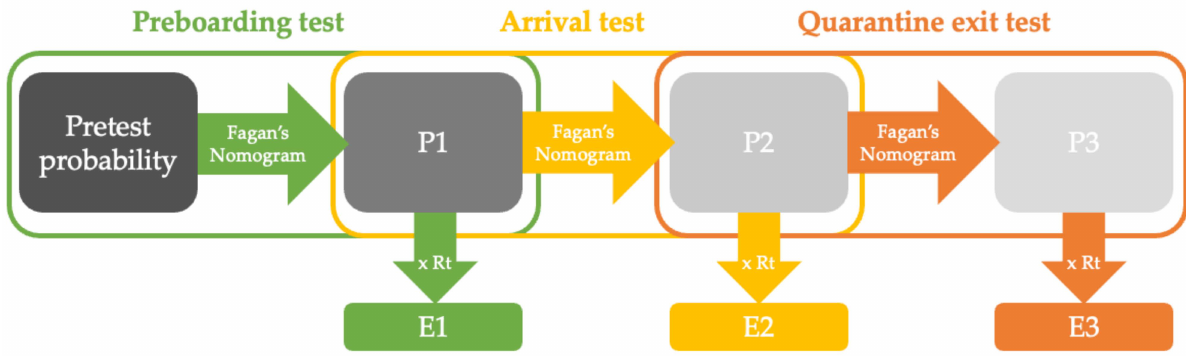
Figure 1. Illustrative summary of the